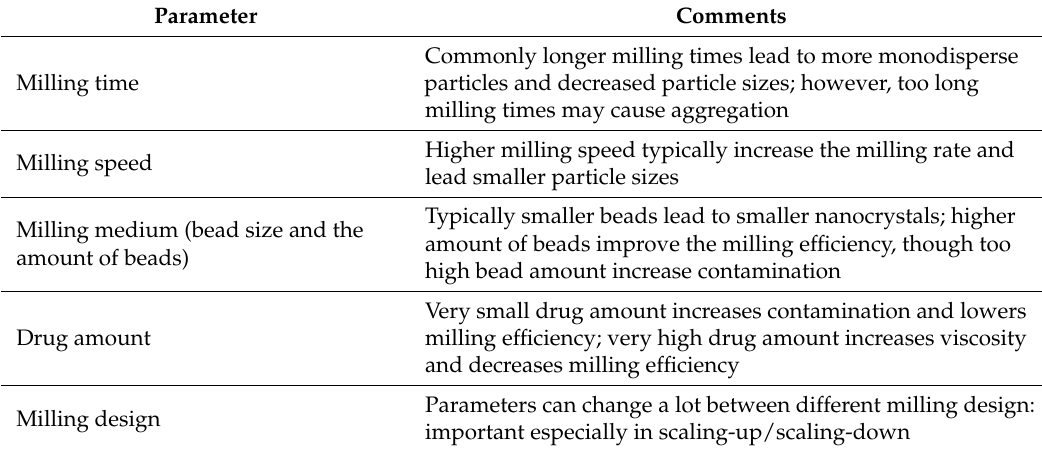
Table 2. Process parameters in milling and their typical impact on final product properties. It should be noticed that normally, several parameters are affecting milling process and the effect of one parameter on the final product properties is not always